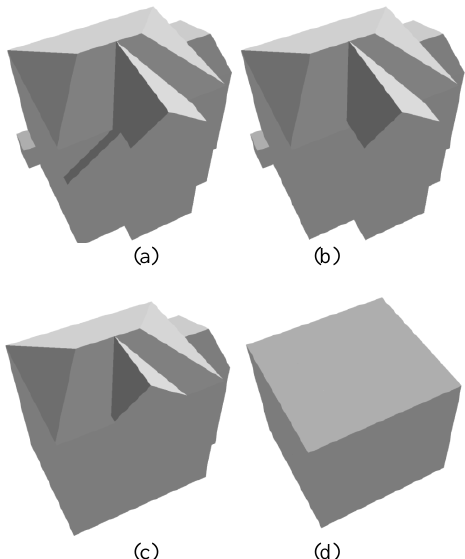
Figure 13. Reconstruced roof model (building in Figure 8d) under different β values: (a) β = 0, (b) β = 0.55, (c) β = 1.0 and (d) β = 1.5.